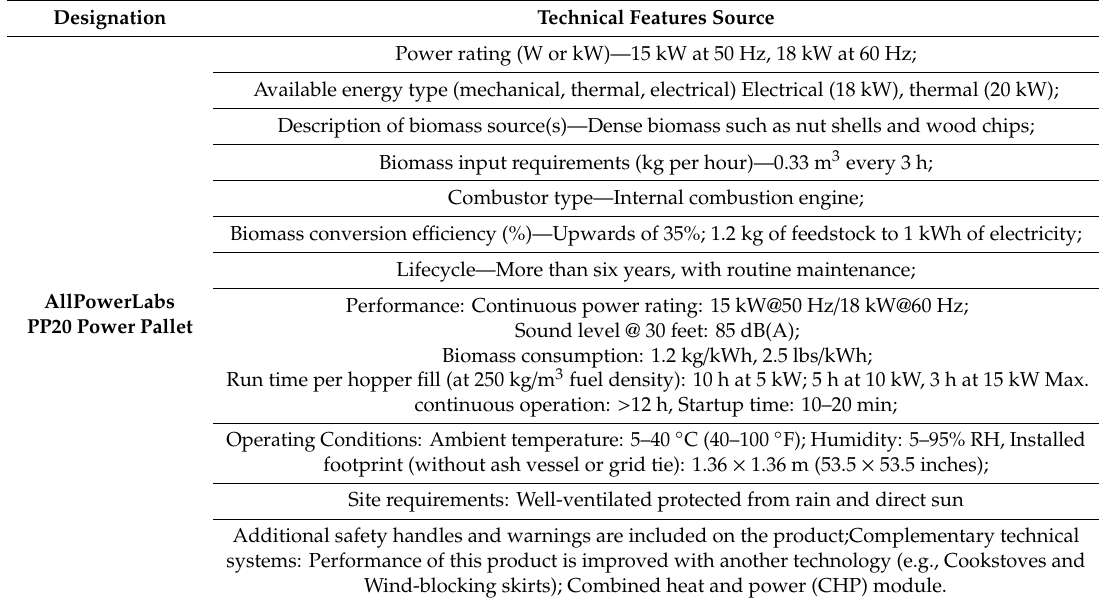
Table 5. Technical characteristics of PP20 Power Pallet—(Source: AllPowerLabs PP20 Power Pallet).